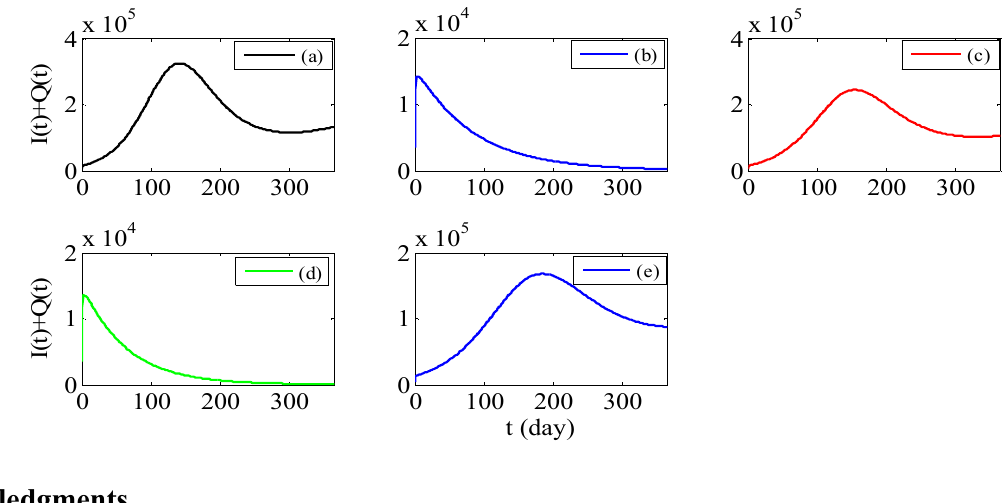
Figure 3. ( a ) Simulation of the sum of not hospitalized infectious ( ) I t and hospitalized infectious ( ) Q t with parameters from the sixth column of Table 2. ( b ) Simulation of the sum of ( ) I t and ( ) Q t with  = 0.6964 (=0.7738 × 0.9), other parameters from the sixth column of Table 2. ( c ) Simulation of the sum of ( ) I t and ( ) Q t with  = 0.005, other parameters from the sixth column of Table 2. ( d ) Simulation of the sum of ( ) I t and ( ) Q t  = 0.8267 (=0.7348 × 1.125), other parameters from the sixth column of Table 2. with 1  = 0.8052 (=0.2013 × 4), other ( e ) Simulation of the sum of ( ) I t and ( ) Q t with 2 parameters from the sixth column of Table